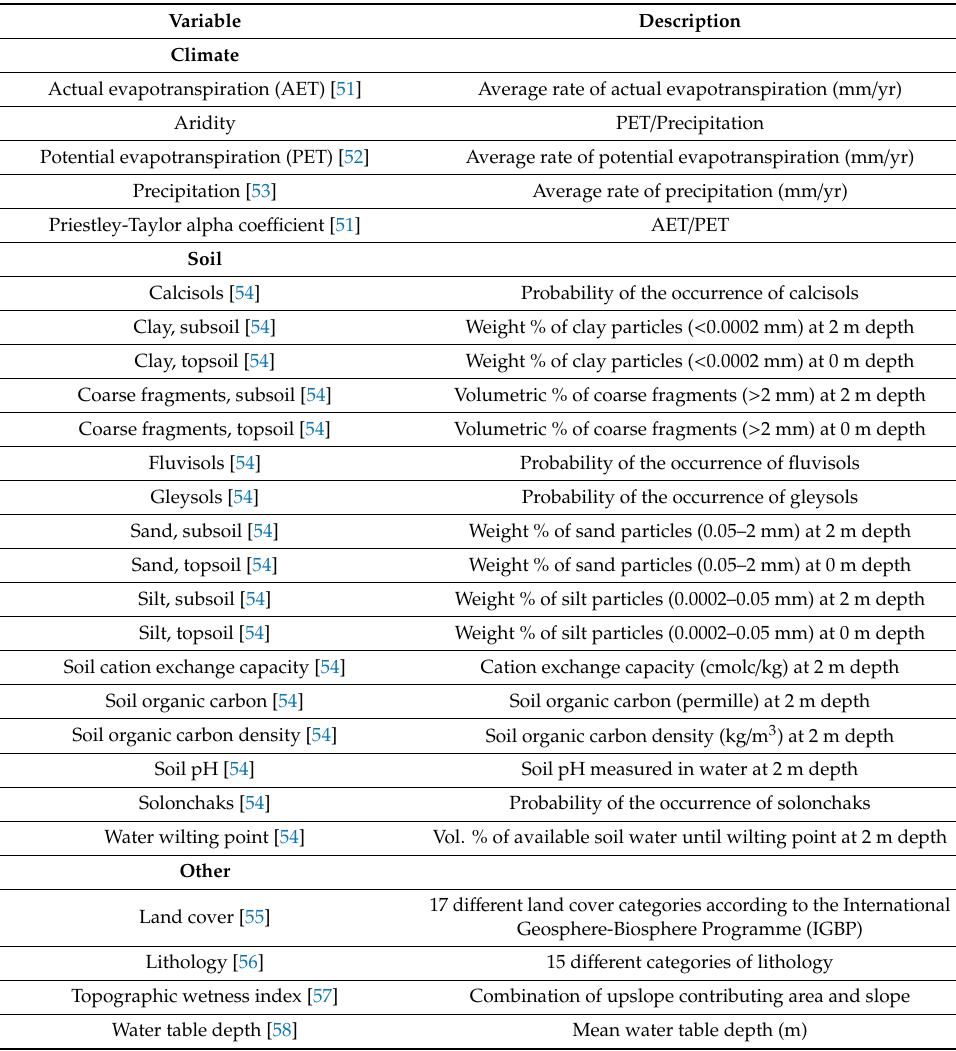
Table 2. Predictor variables and descriptions. The 26 parameters used as predictor variables in modeling are grouped into the categories ‘Climate’, ‘Soil’ and ‘Other’. Their resolution is one square km at the